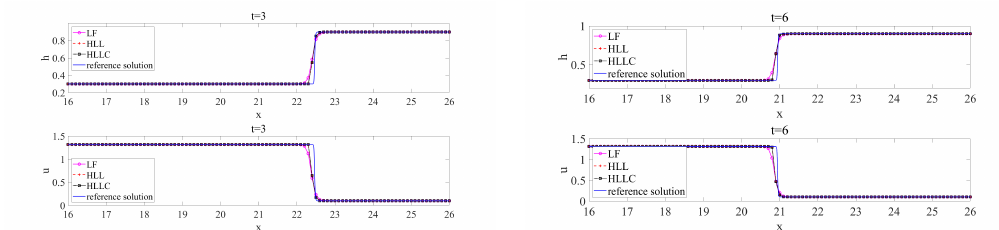
Figure 2. Depth and corresponding velocity profiles with WENO–LF, WENO–HLL, and WENO– HLLC fluxes at t = 3,6.